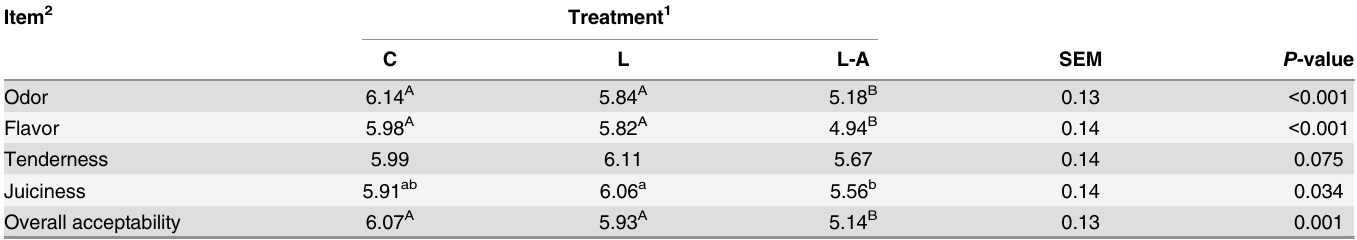
Table 8. Effects of addition of linseed or linseed and marine algae to the diet on sensory evaluation of longissimus dorsi